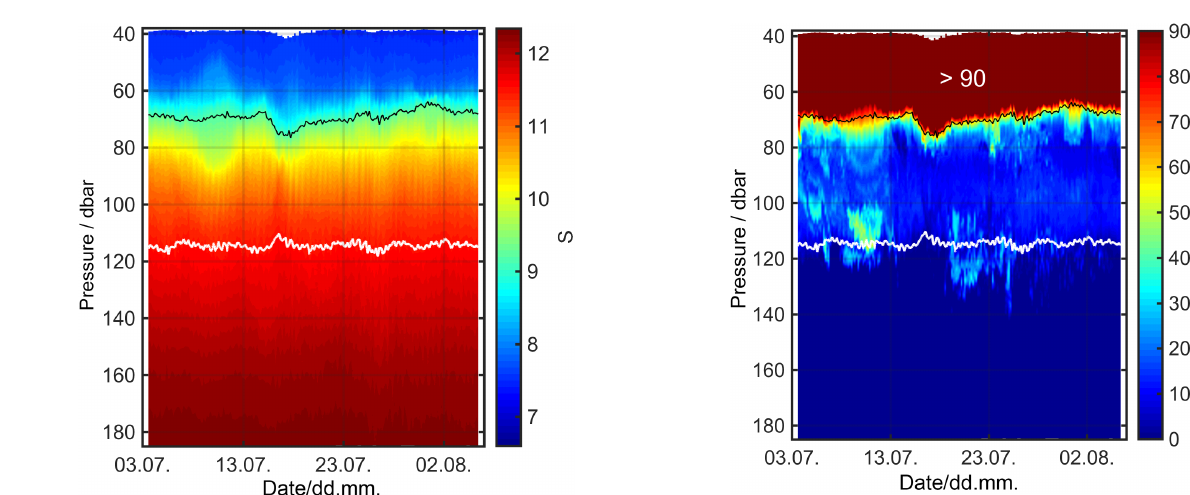
Figure 8. Plot of salinity in practical salinity units (colour-coded) over deployment date and pressure for the second deployment, 3 July–5 August 2010. The lines at around 70dbar (black) and around 115dbar (white) denote the isopycnals of 1007.6 and 1009.5kgm − 3 respectively, indicating the division between oxic and hypoxic (upper line) and between hypoxic and anoxic waters (lower line).